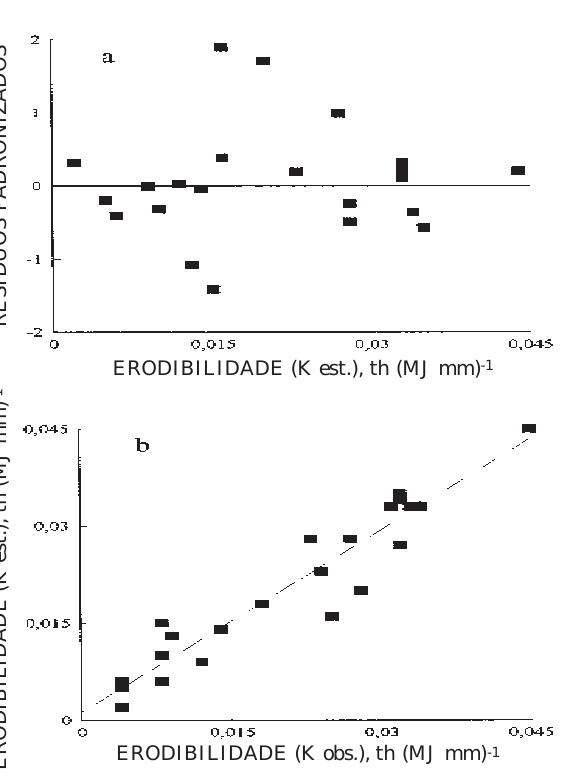
Figura 3. Resíduos padronizados (a) e relação entre os valores observados e estimados do fator K pela equação 4 (b). Na figura 3 b o traço contínuo representa a linha